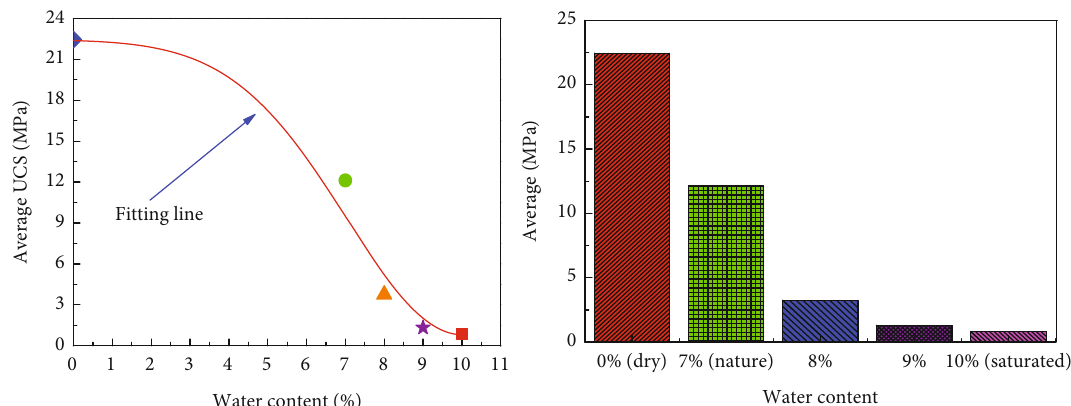
Figure 5: Average UCS of mudstone samples under di ff erent water contents.